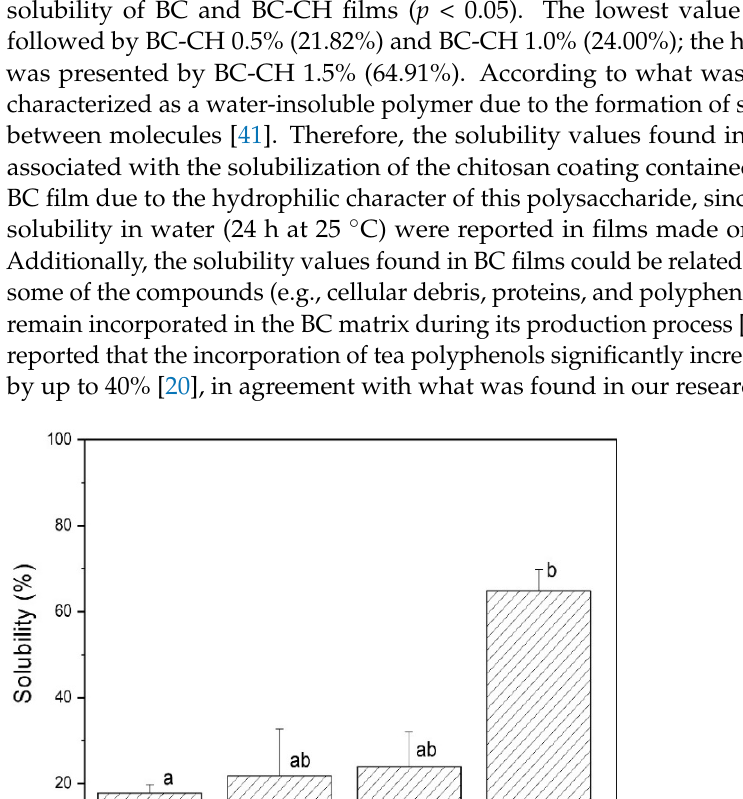
Figure 8. UV ‐ Visible spectra of BC and BC ‐ CH films coated with various concentrations of chitosan.